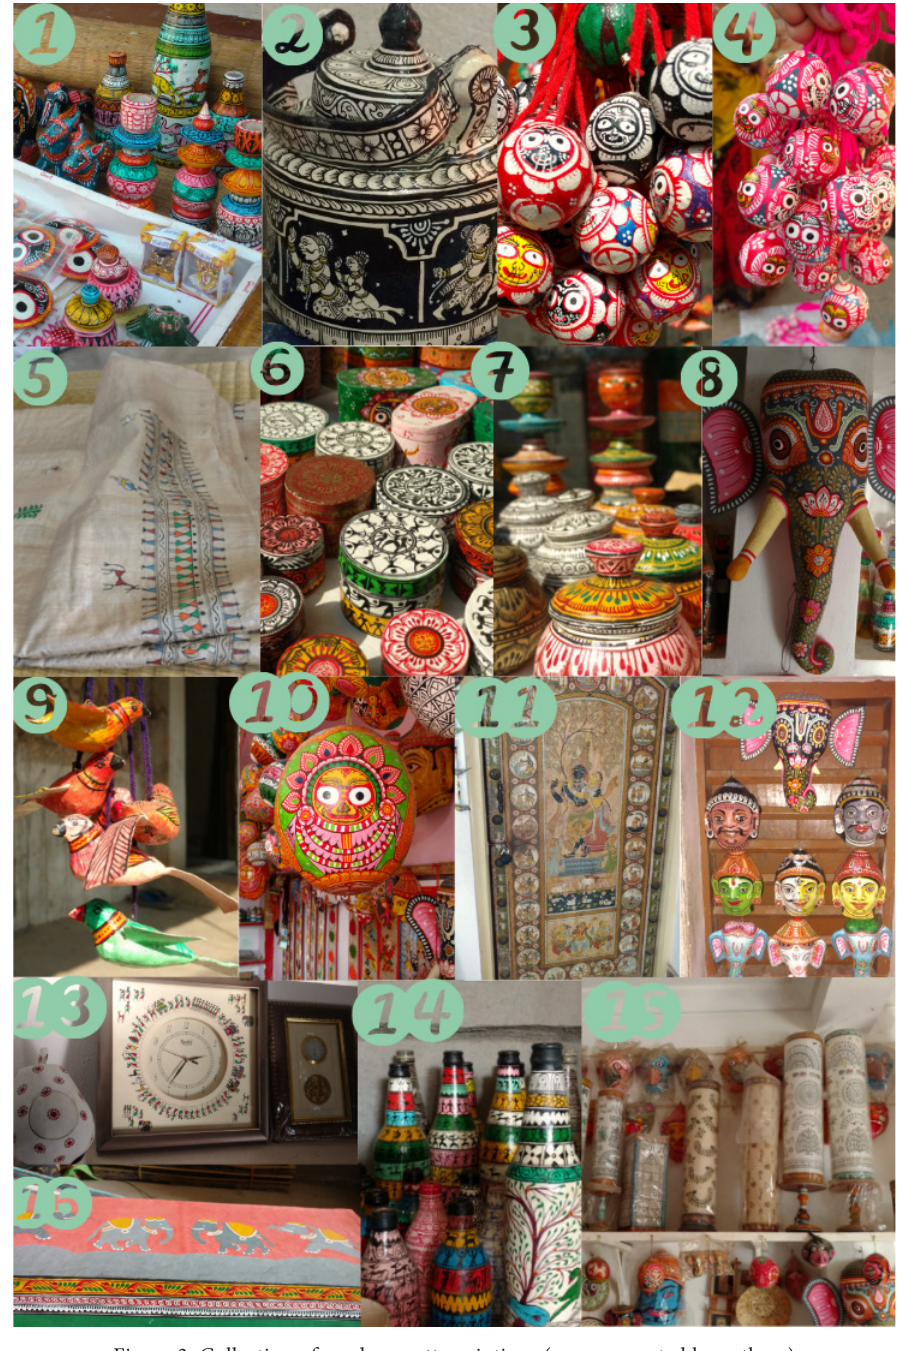
Figure 3. Collection of modern patta paintings (source: created by